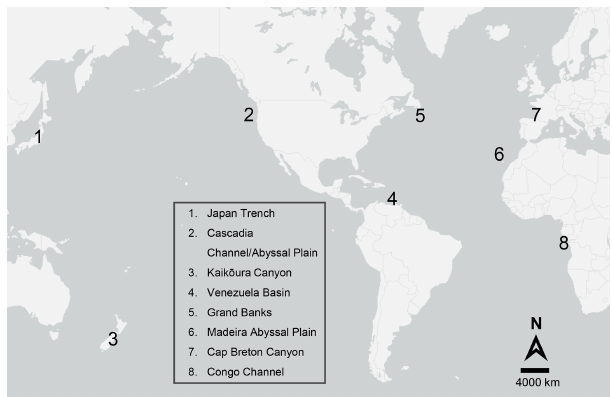
Figure 3. Map showing the approximate location of the turbidity flows reviewed in this paper. See Table 1 for additional